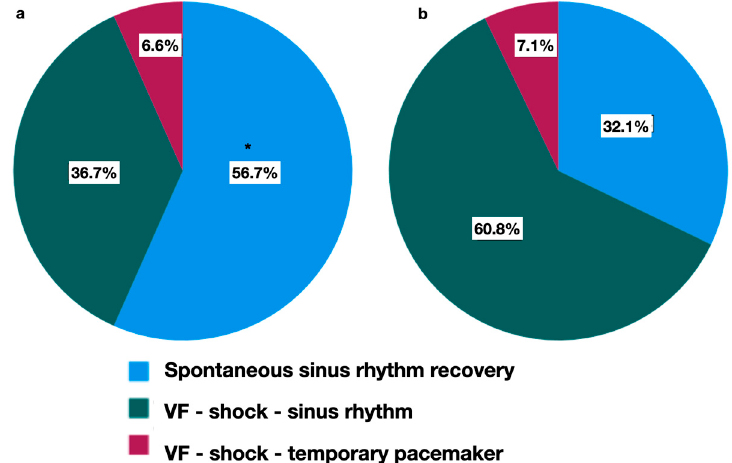
Figure 4. Heart rhythm recovery. The HHP group ( a ) and the control group ( b ) in the postperfusion period. Types of rhythm recovery: (Blue) spontaneous sinus rhythm recovery; (Green) ventricular fibrillation (VF) after aorta declamping, sinus rhythm recovery after defibrillation; (Red) ventricular fibrillation after aorta declamping, atrioventricular blockade after defibrillation, the need for temporary pacing. *— p = 0.008 between groups.